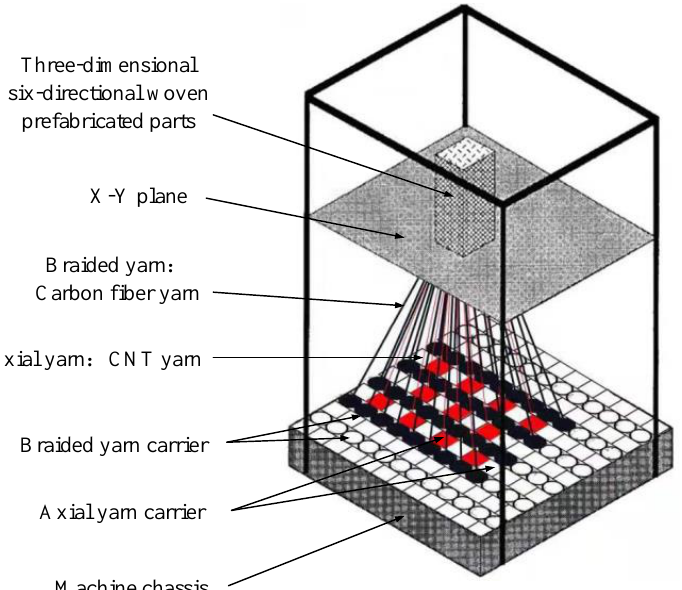
Figure 1. Schematic diagram of 3D braiding machine.